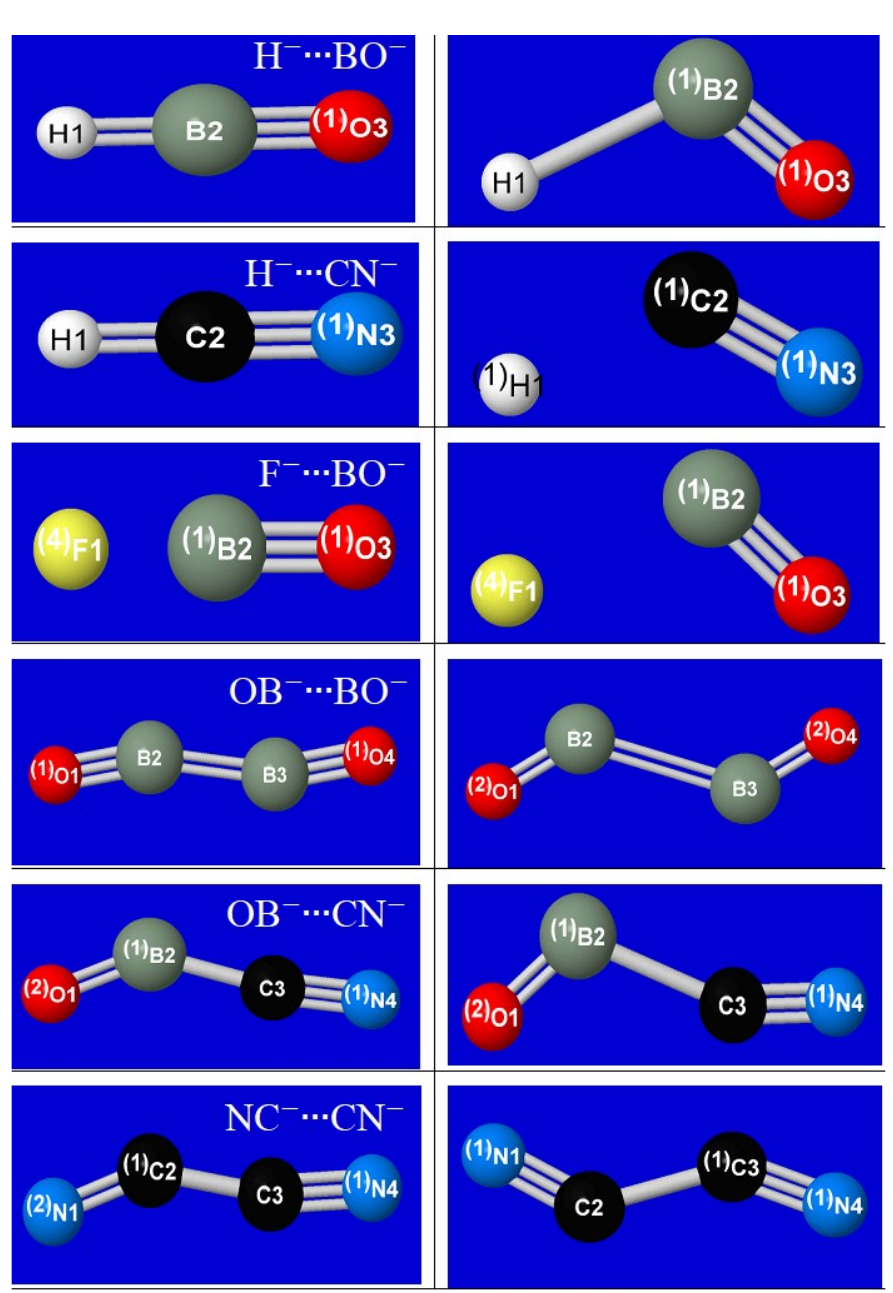
Figure 1. Computed B3LYP/6-311++G** equilibrium ( left ) and transition-state ( right ) structures for like-charge pi-hole complexes (from top to bottom row: H − ···BO − , H − ···CN − , F − ···BO − , OB − ···BO − , OB − ···CN − , NC − ···CN − ), showing nominal NLS (natural Lewis structure) bonding pattern (for α -spin, if biradicaloid) for each species at the depicted geometry.